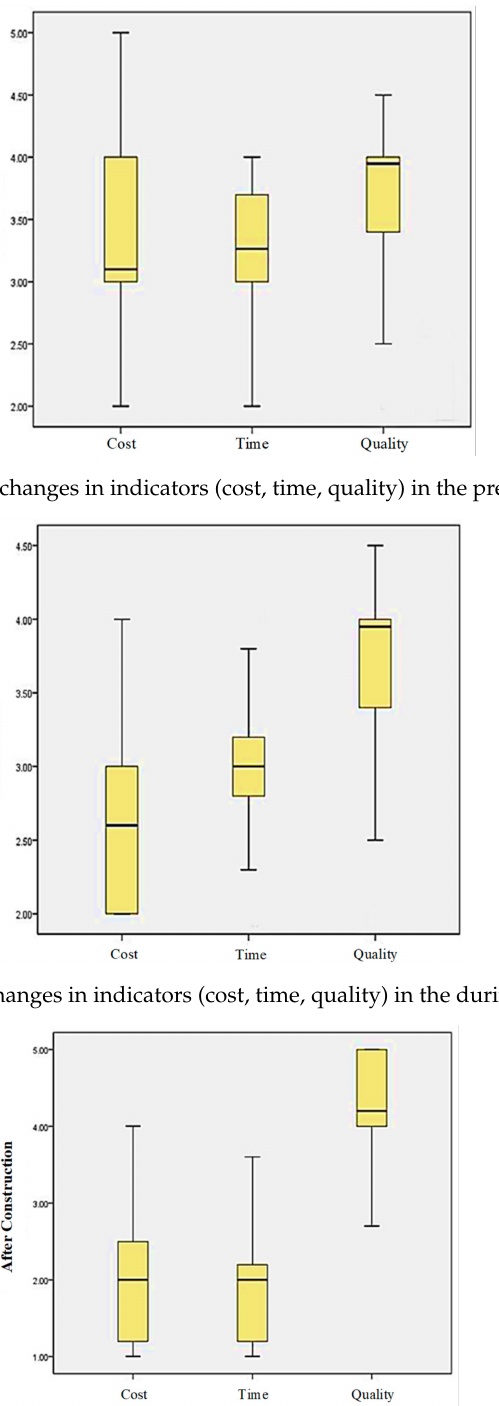
Figure 4. Comparison of changes in indicators (cost, time, quality) in the post-construction